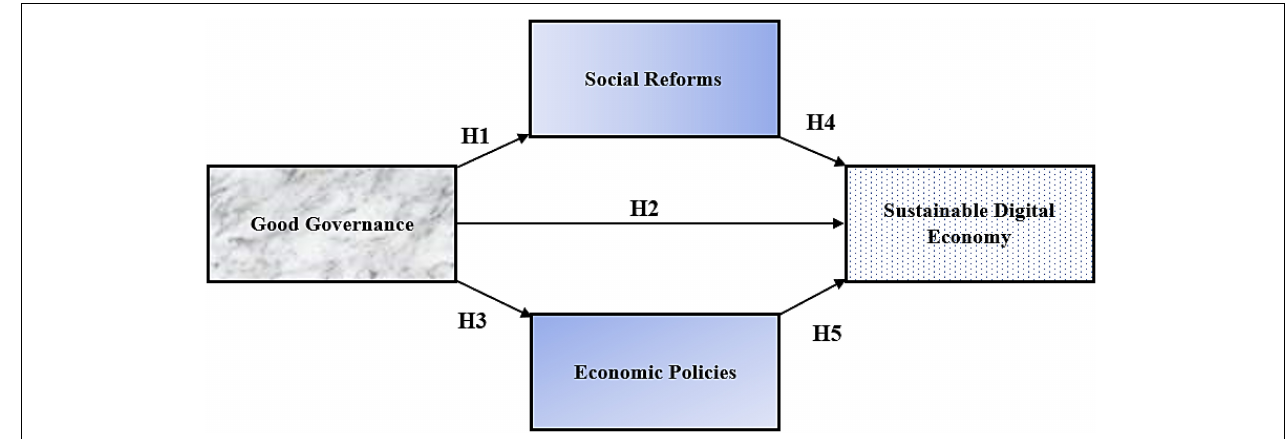
FIGURE 1 | Conceptual